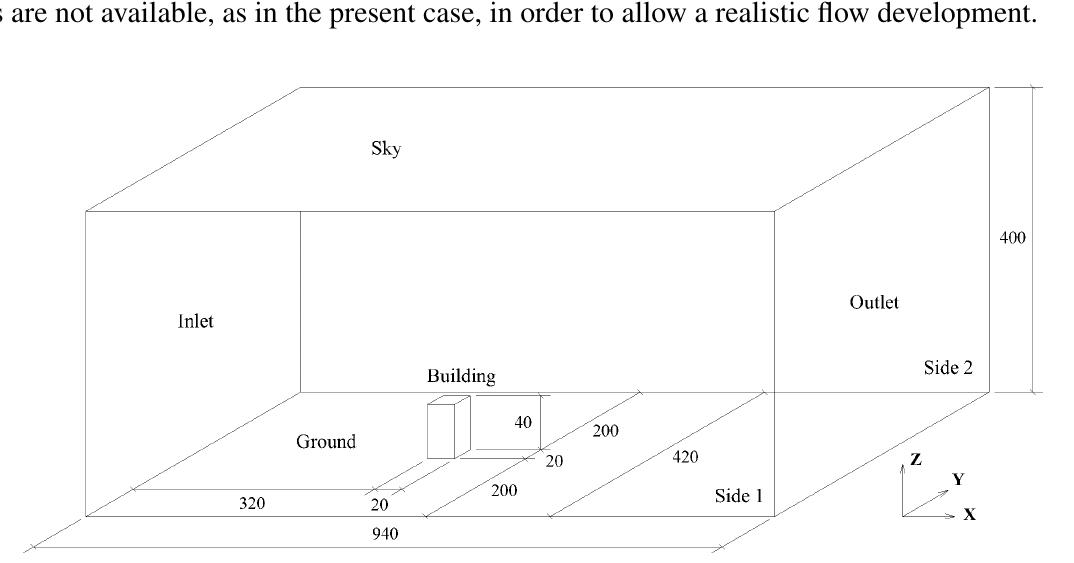
Figure 6. Diagram of the computational domain of the base-building (flat roof). All values are in